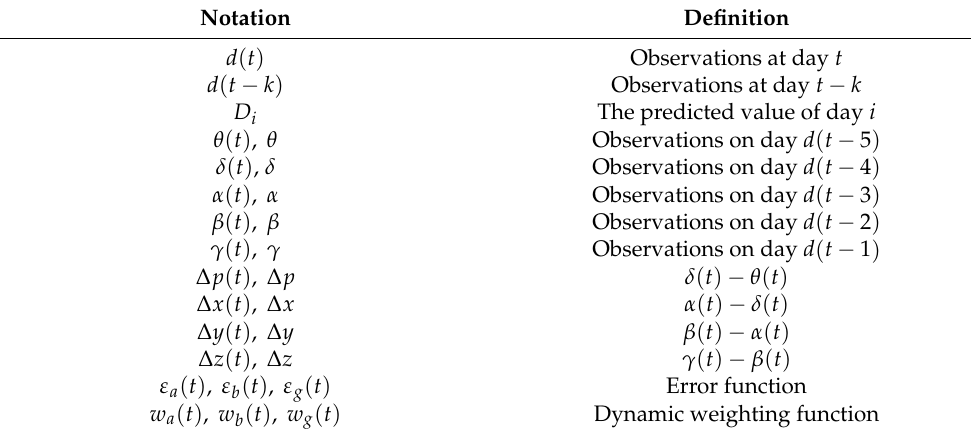
Table 2. Notation of